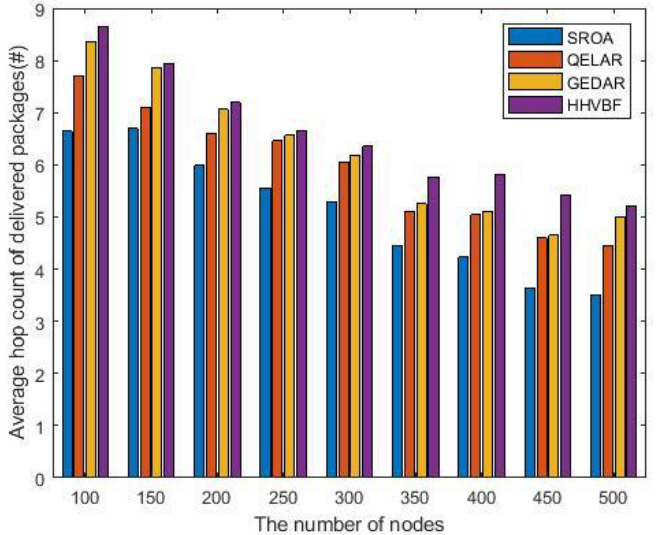
Figure 13. Comparison of the average hop count for the four protocols.